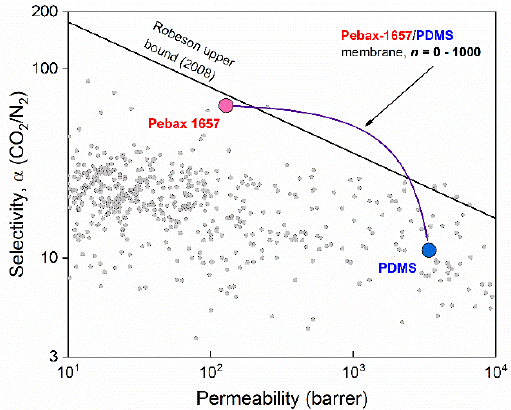
Figure 5. Resistance model predictions for the CO 2 permeability of the composite membrane vs. CO 2 /N 2 selectivity located in respect to the Robeson upper bound [4] and a number of the reported literature data (grey points) taken from the open database.